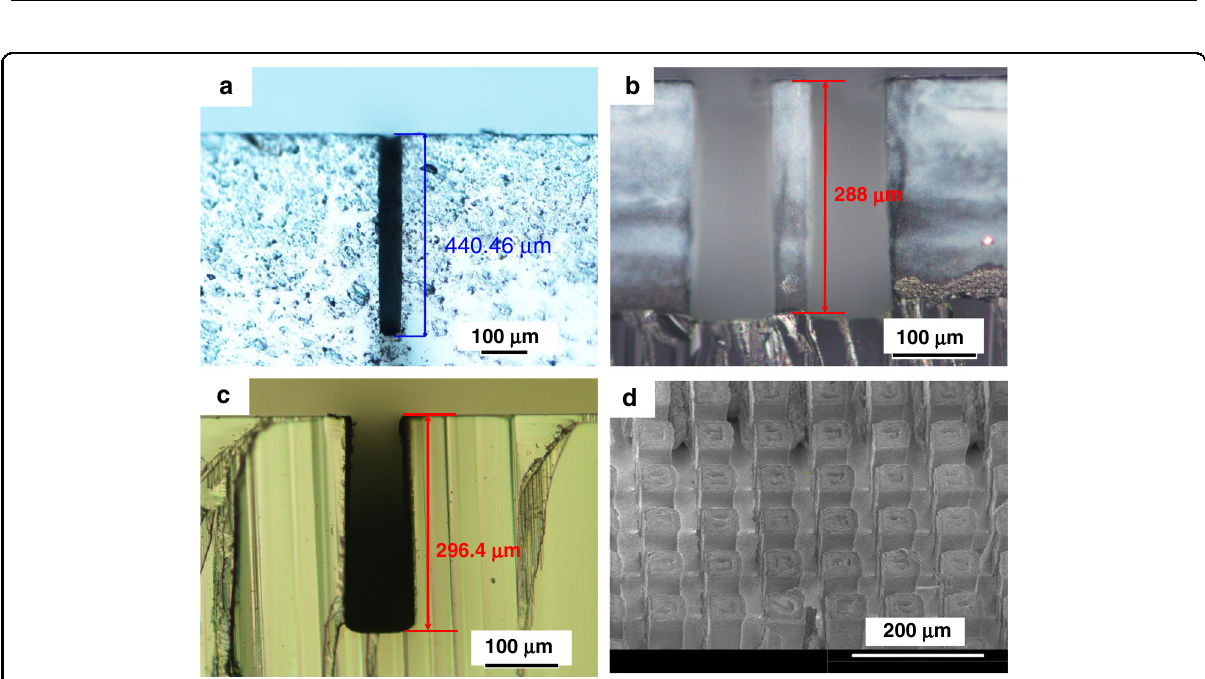
Fig. 8 Microstructures fabricated in sapphire by femtosecond laser LIPAA 45 . a Taper-free, high-aspect-ratio (>10) deep micro-channel. b Single micro-column. c Trapezoid micro-channel. d Micro-column array. Reproduced with permission from ref. 45 © 2020 Elsevier Ltd. All rights